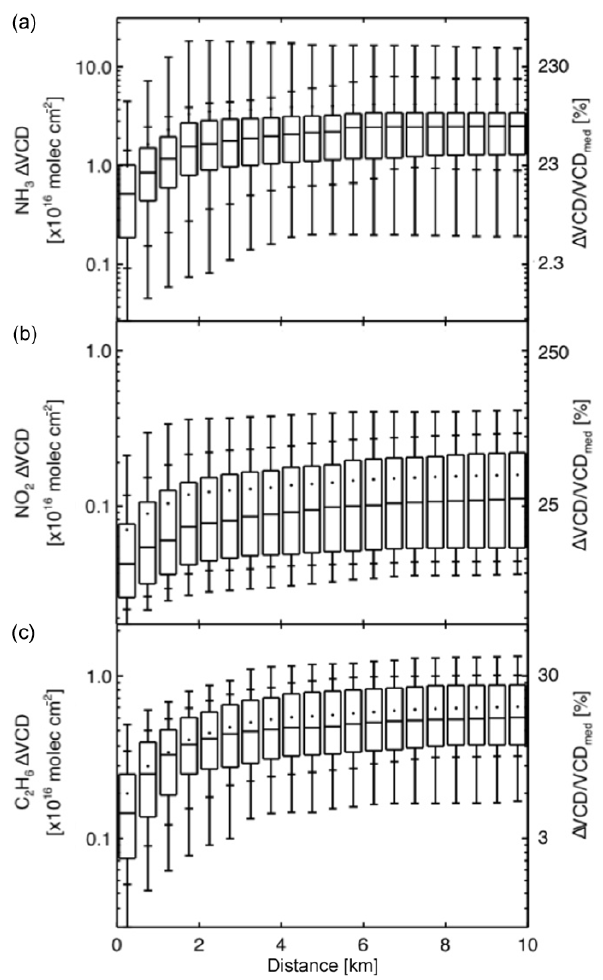
Figure 9. Structure functions of (a) NH 3 , (b) C 2 H 6 and (c) NO 2 using data from RD11 with a time constraint of 30min for the time period of the five sites. The bin width is 500m. Boxes mark 25th and 75th percentiles, the dot indicates the mean and the line inside the box marks the median. Dashes below and above the boxes indicate 5th, 15th, 85th and 95th